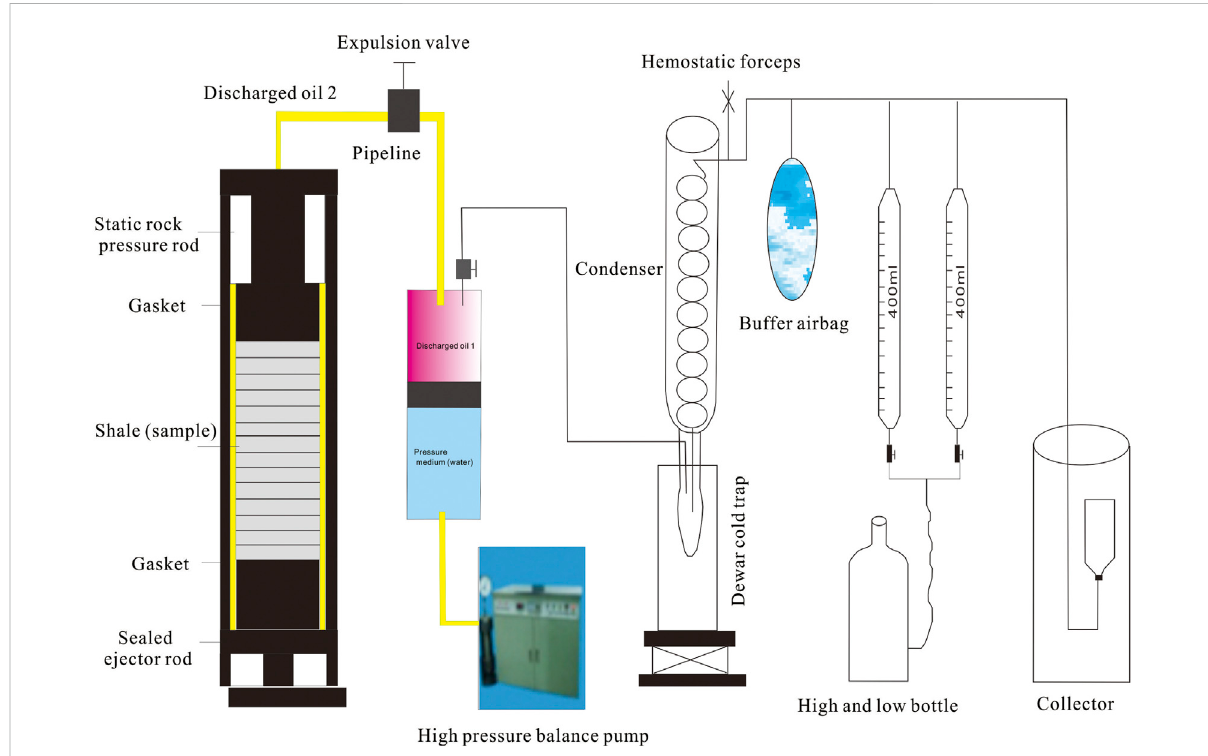
FIGURE 3 Hydrous pyrolysis system for hydrocarbon generation and expulsion of pure shale (model 2).